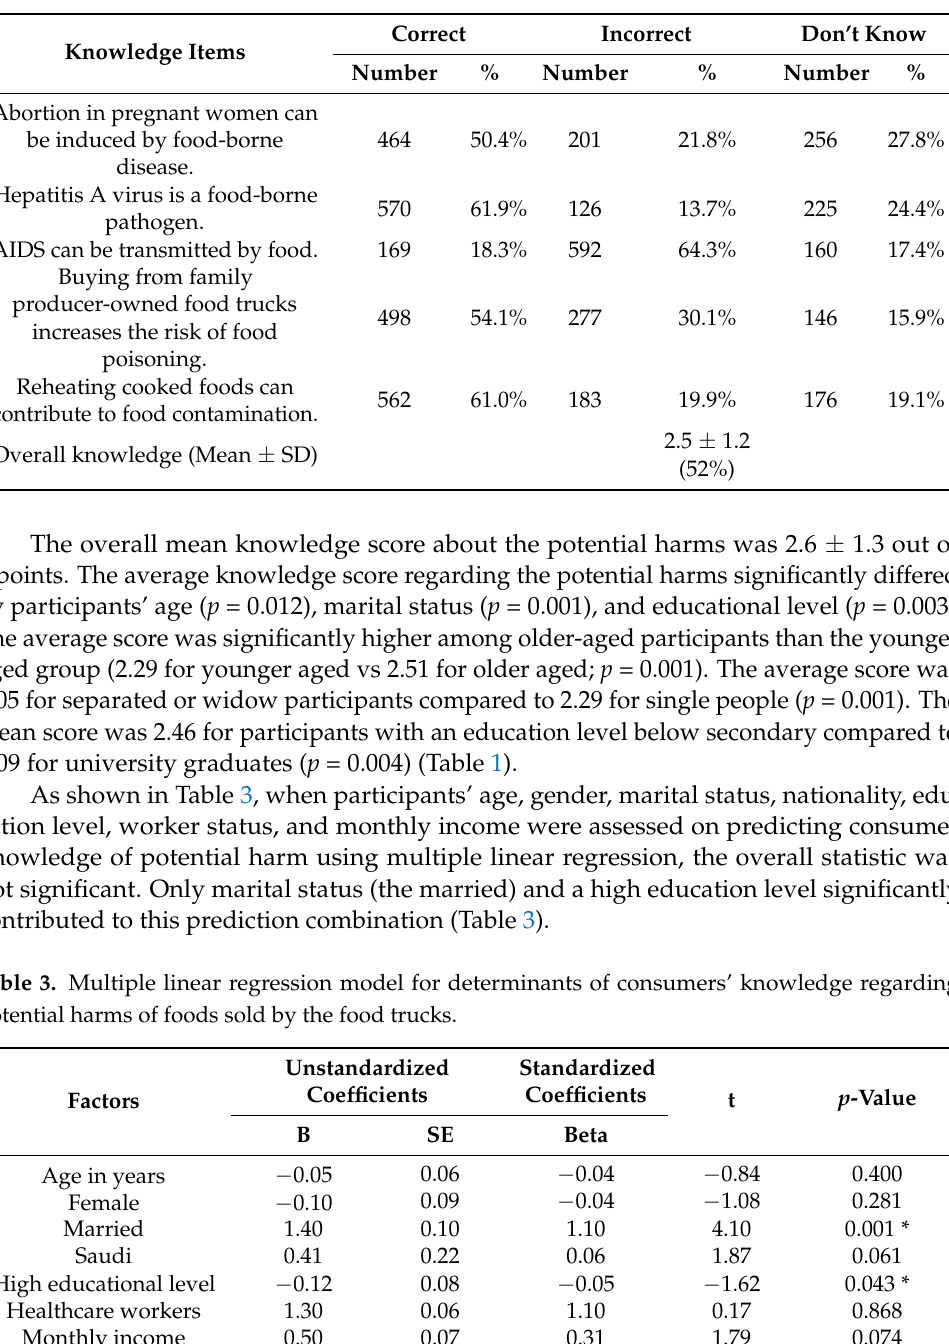
Table 2. Distribution of participants’ level of knowledge about the potential harms of foods sold by the productive families-owned food trucks.